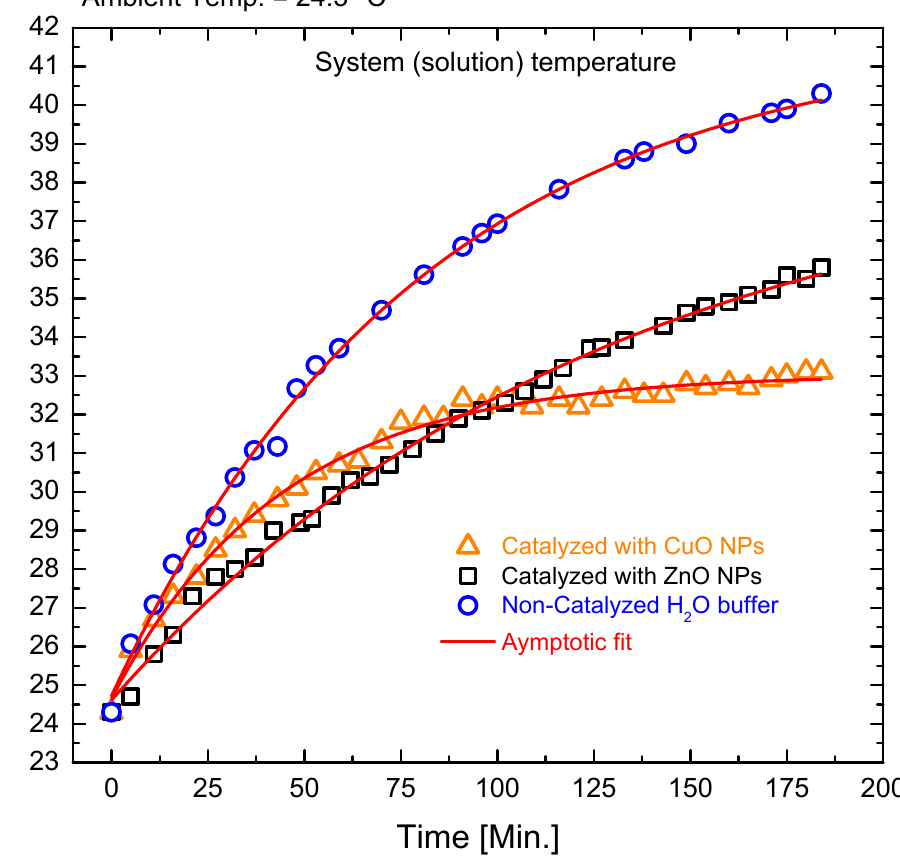
Figure 7. Temperature (T) versus period of Time (t) characteristics for the non-catalyzed system and the catalyzed systems with CuO NPs and ZnO NPs.